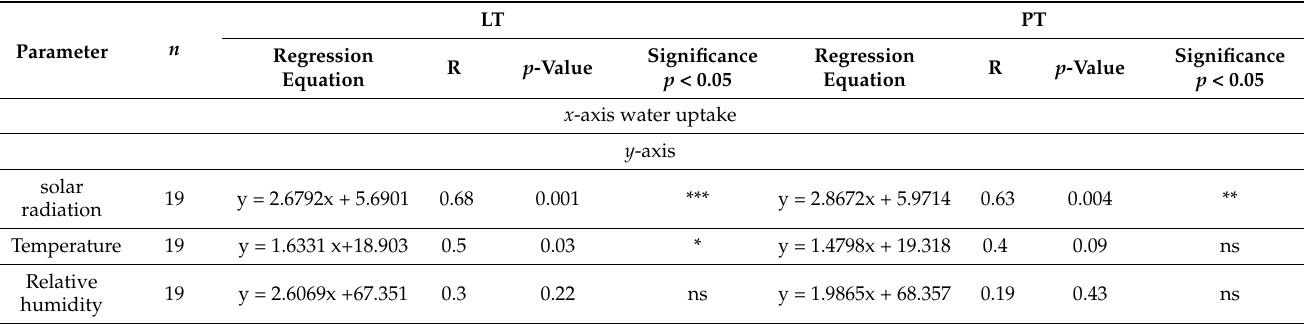
Table 4. Correlation between greenhouse environmental factors and water uptake.